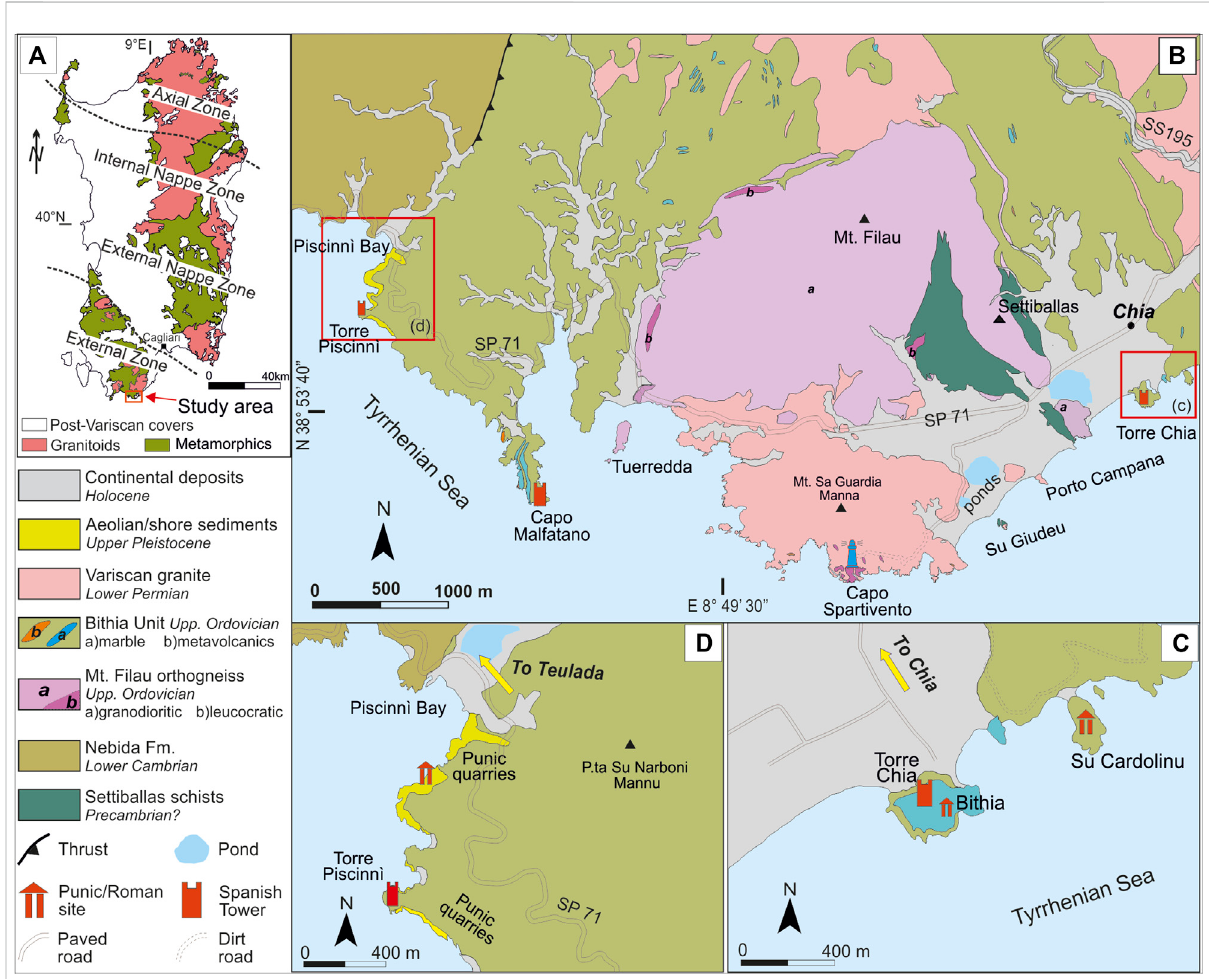
FIGURE 1 (A) Geological sketch map of Sardinia (after Carmignani etal., 2001, modi fi ed); (B) geological sketch mapof the studied area, including all stops of the proposed itinerary (after Cruciani et al., 2018, modi fi ed); (C,D) details of the fi rst and last stops, respectively, showing geological features not visible in the (B)